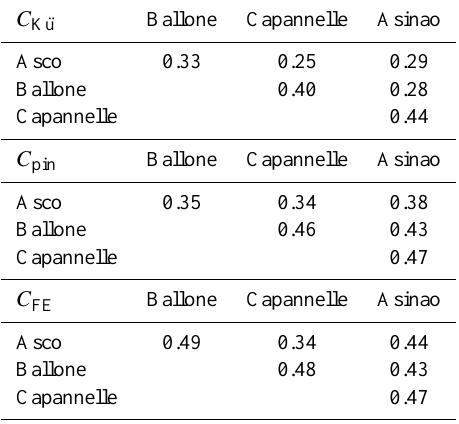
Table 2. Pearsons correlation coefficients between chronologies corrected with correction factors from K¨urschner (1996; C K¨u ) and Feng and Epstein (1995; C FE ) as well as the pin-correction (McCar- roll et al., 2009; C pin ). Correlations are calculated over the common time period 1582–2007AD.